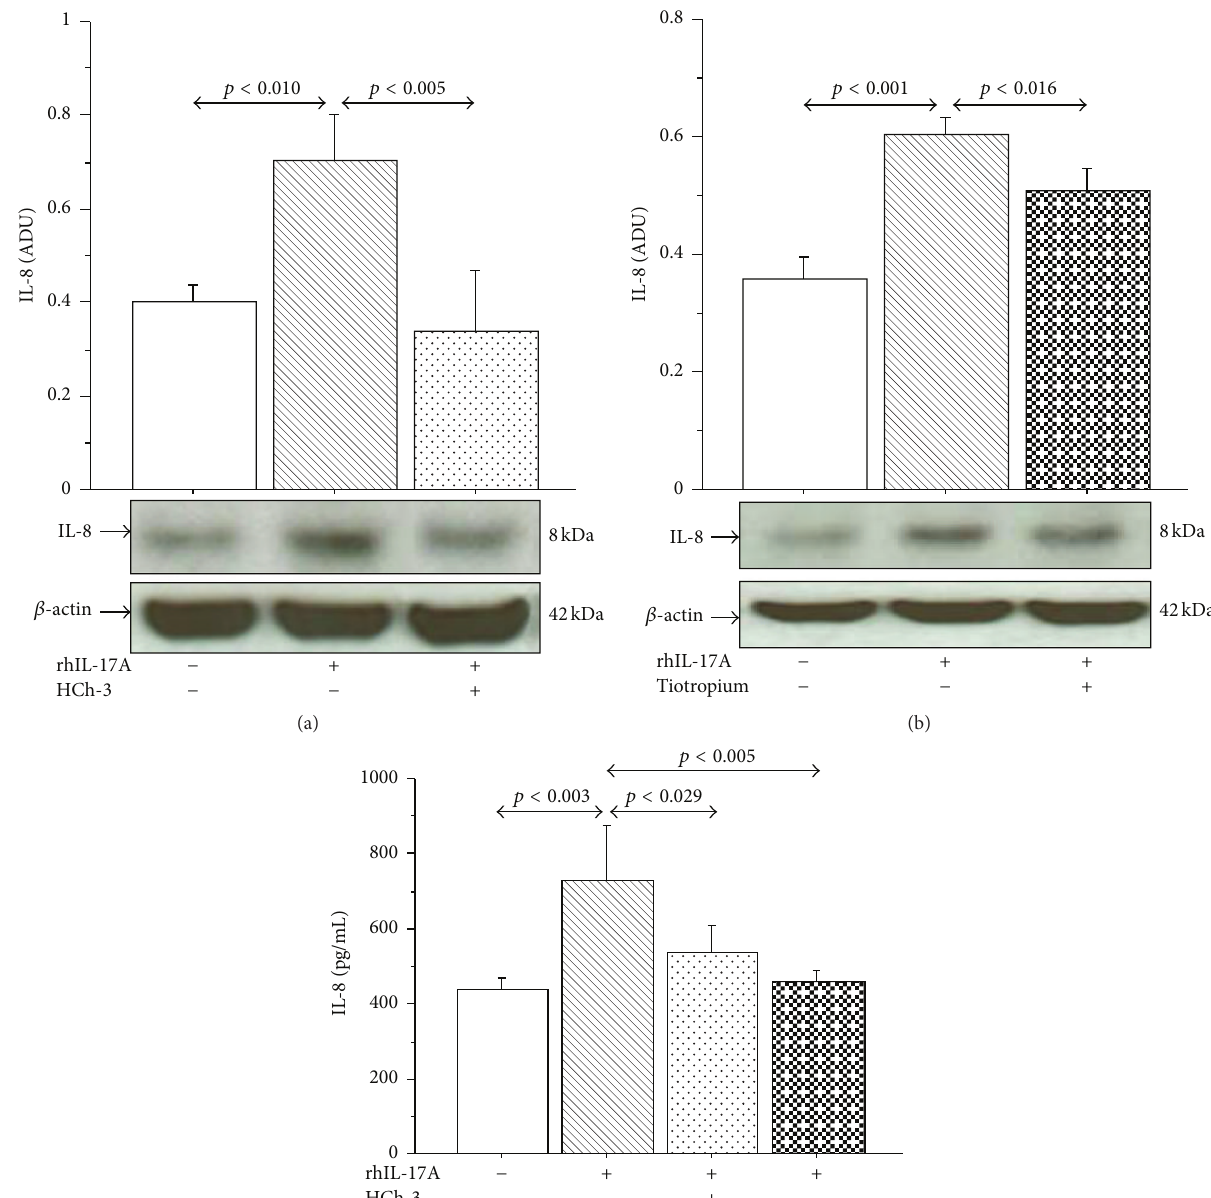
Figure 6: Effect of Hemicholinium-3 (HCh-3) or Tiotropium on IL-8 production in 16-HBE cells. Cells were preincubated for 1h with HCh-3 (50 𝜇 M) or Tiotropium (100nM) and then stimulated with rhIL-17A 20 ng/mL for 24 h to evaluate ((a)-(b)) IL-8 expression by western blot. Bars represent mean ± SD of arbitrary densitometric units (ADU). Representative western blot analyses of IL-8 protein and 𝛽 -actin are shown. (c) IL-8 release (pg/mL, by ELISA). The values shown are the mean ± SD of three separate experiments. Statistical analysis was performed by ANOVA test followed by Fisher’s PLSD multiple comparison